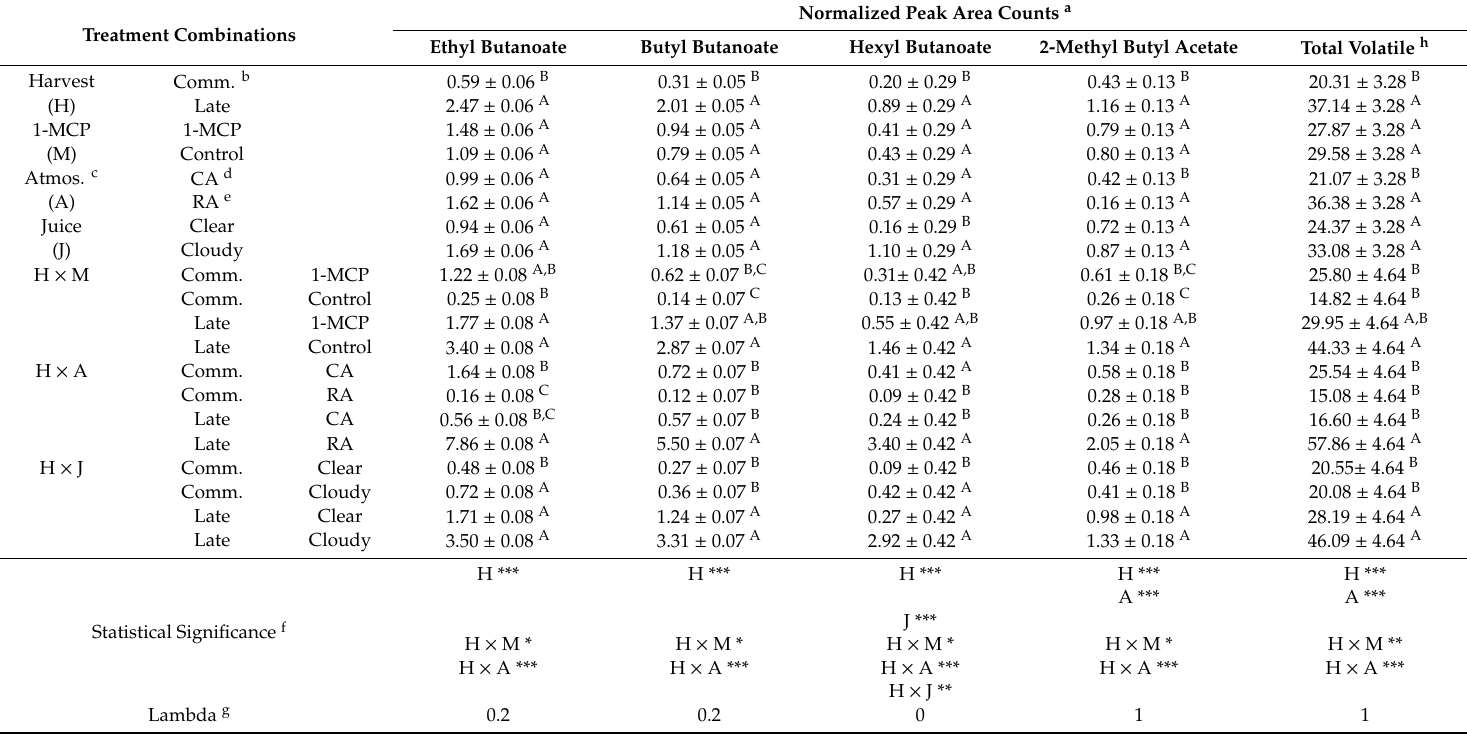
Table 2. The relative amounts of major esters and total volatile compounds identified in clear and cloudy juice samples from McIntosh apples harvested at commercial or late-harvest maturity, treated, or untreated with 1-MCP and stored under CA or RA conditions for 4